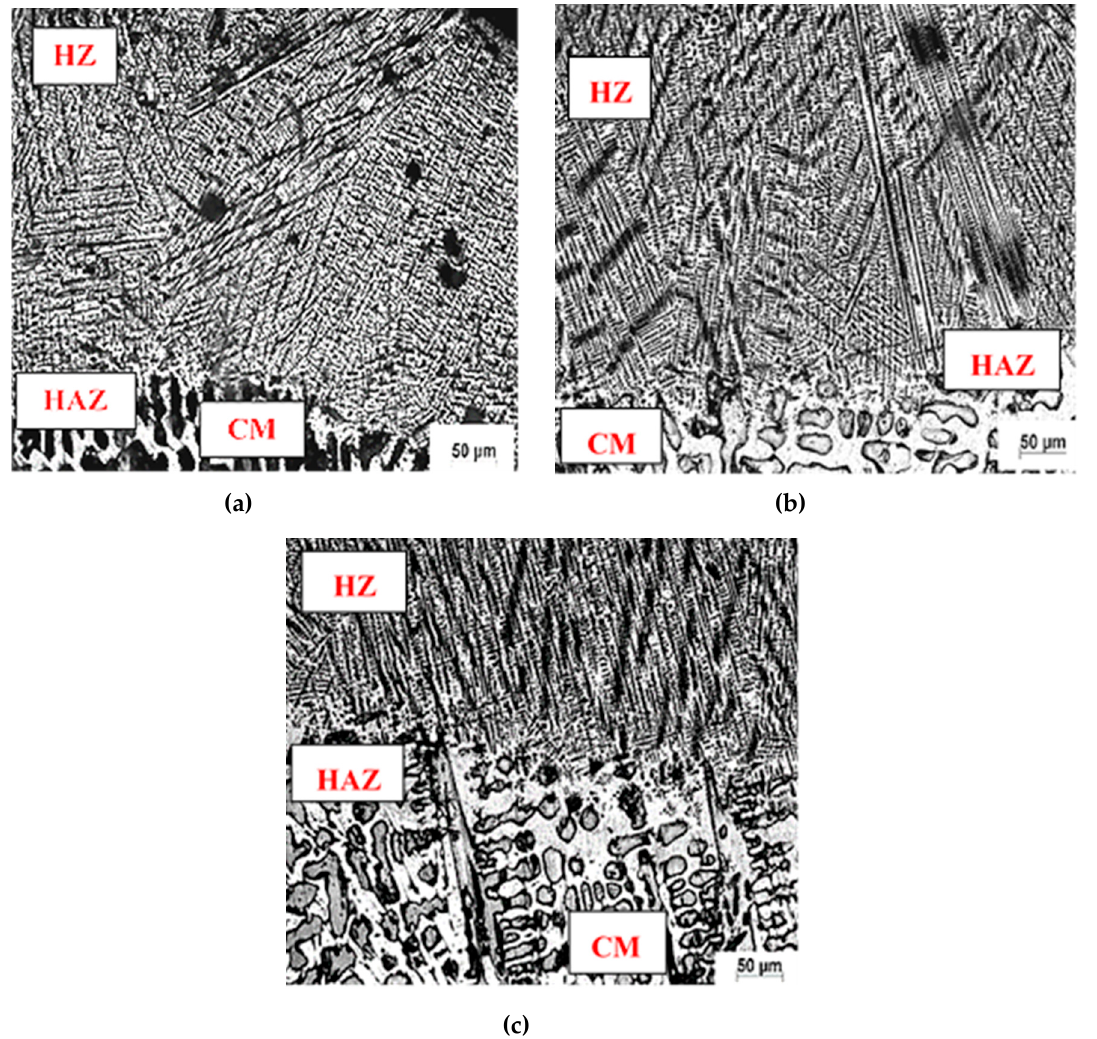
Figure 5. Typical microstructure features of laser heat-treated (LHT) S1 (Ni-hard 1) samples at a constant power of 1000 W and different laser scanning speeds: ( a ) 3; ( b ) 4; ( c ) and 5 m·min − 1 .